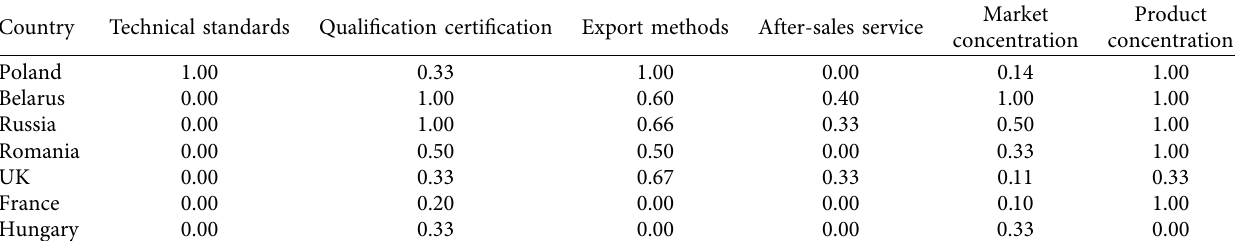
Table 14: Matching indicators value of Chinese power companies in